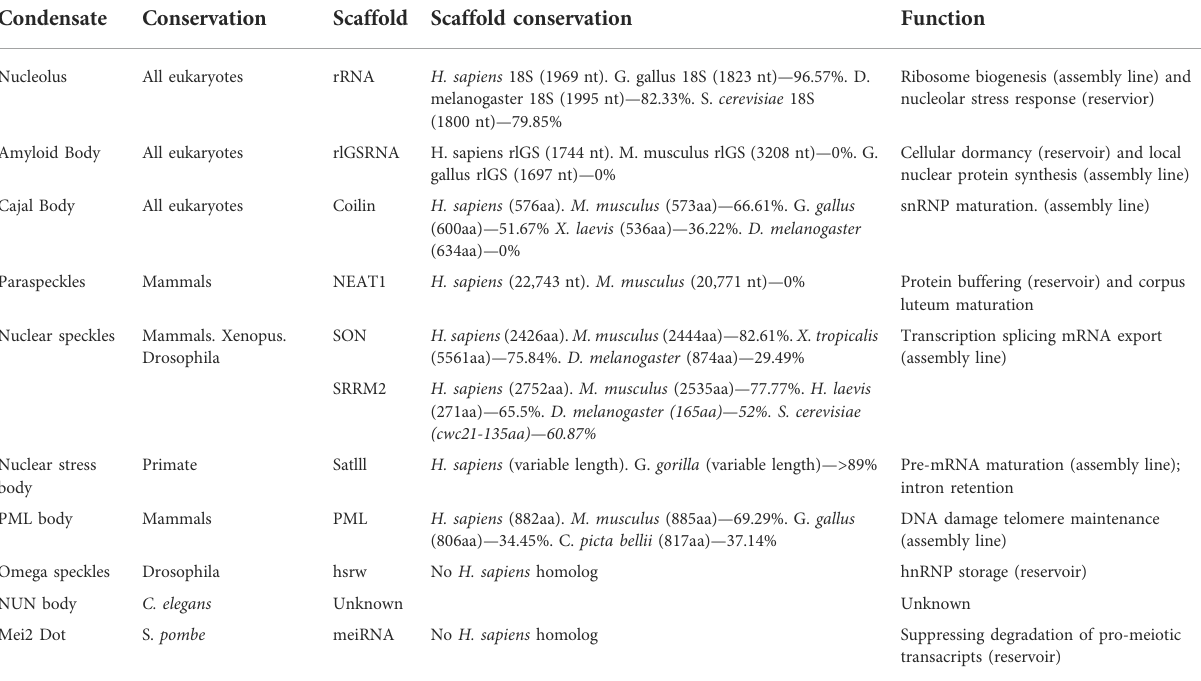
TABLE 1 A comparison of nuclear biomolecular condensates and their scaffolding molecules across eukaryotes. Percentage of alignments were generated using NCBI protein or nucleotide BLAST alignment tools.